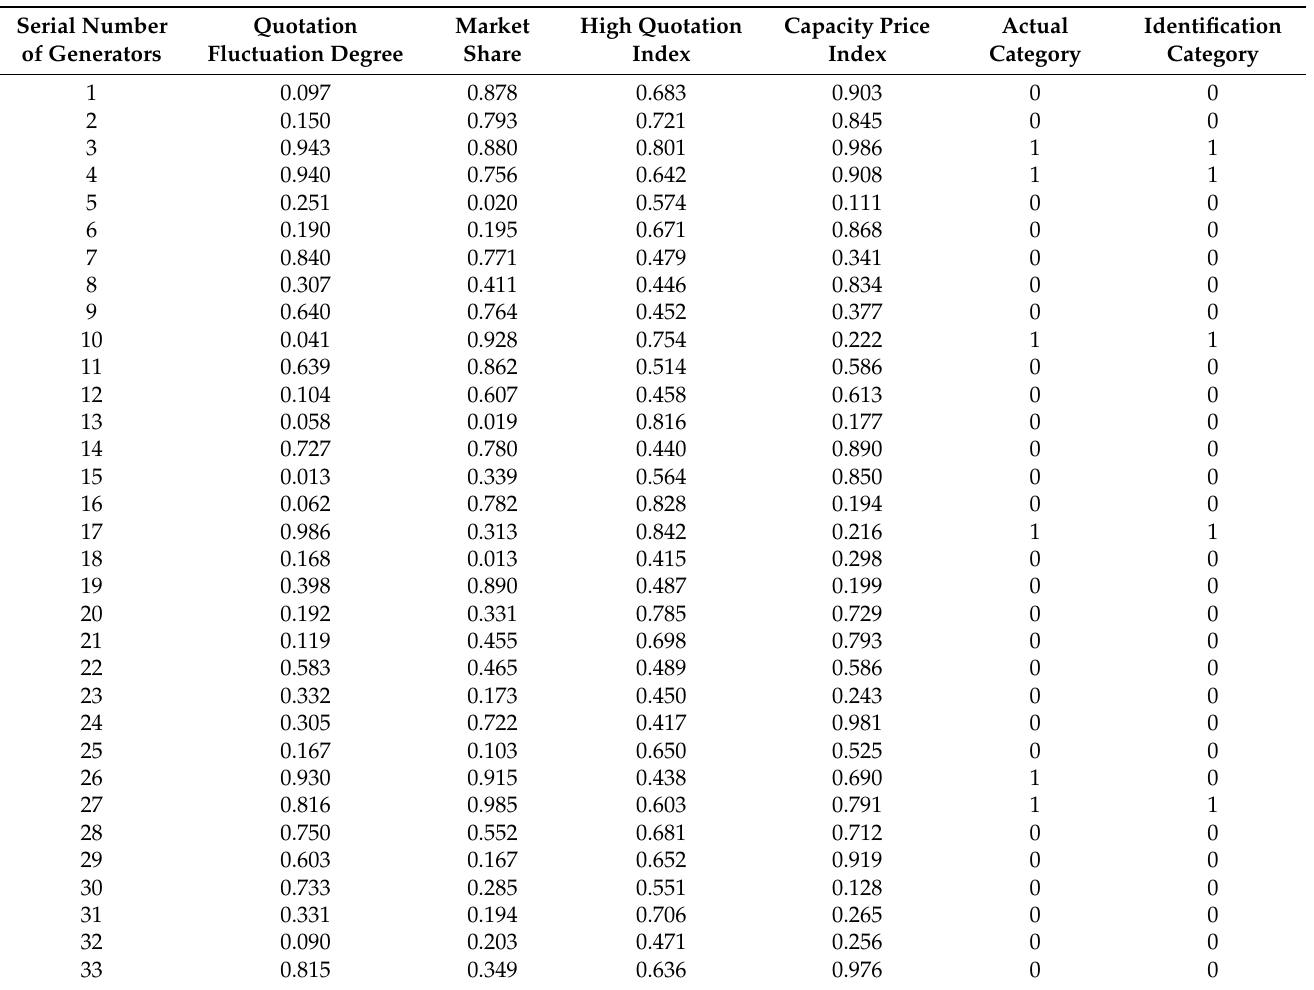
Table A3. A part of the indicator data of generators and identification